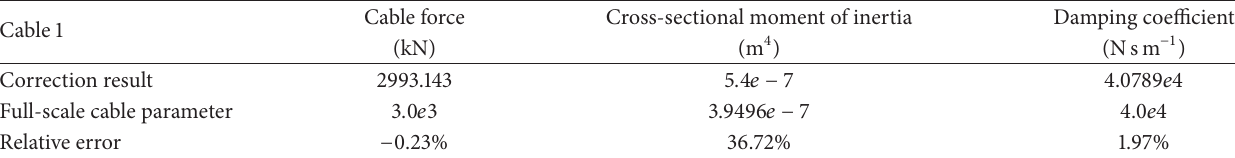
Table 4: Model updating results for simulated cable B01.